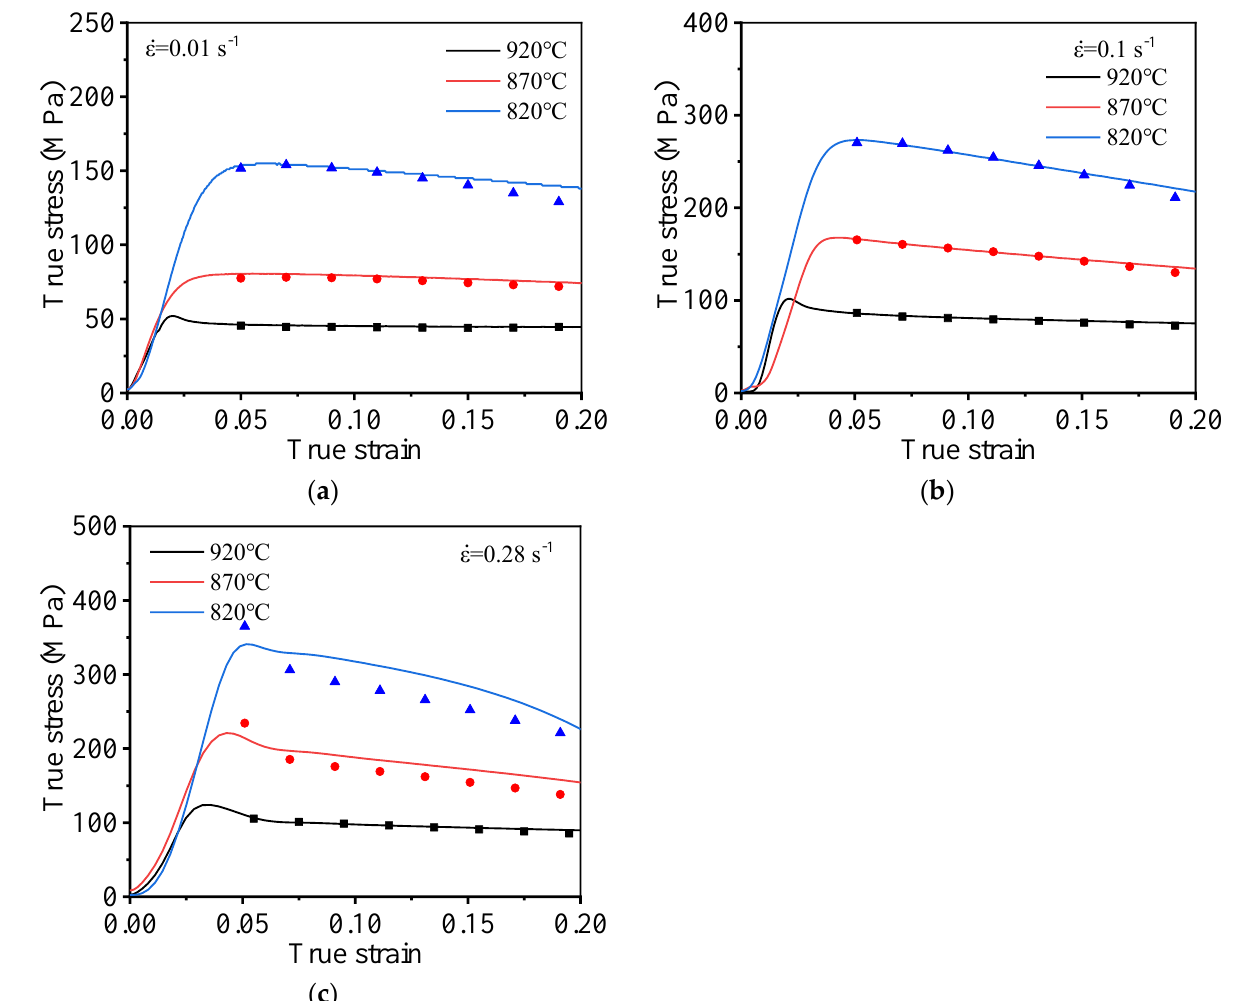
Figure 11. Experimental and predicted values at different deformation conditions: ( a ) 0.01 s −1 ; ( b ) 0.1 s −1 ; ( c ) 0.28 s −1 .